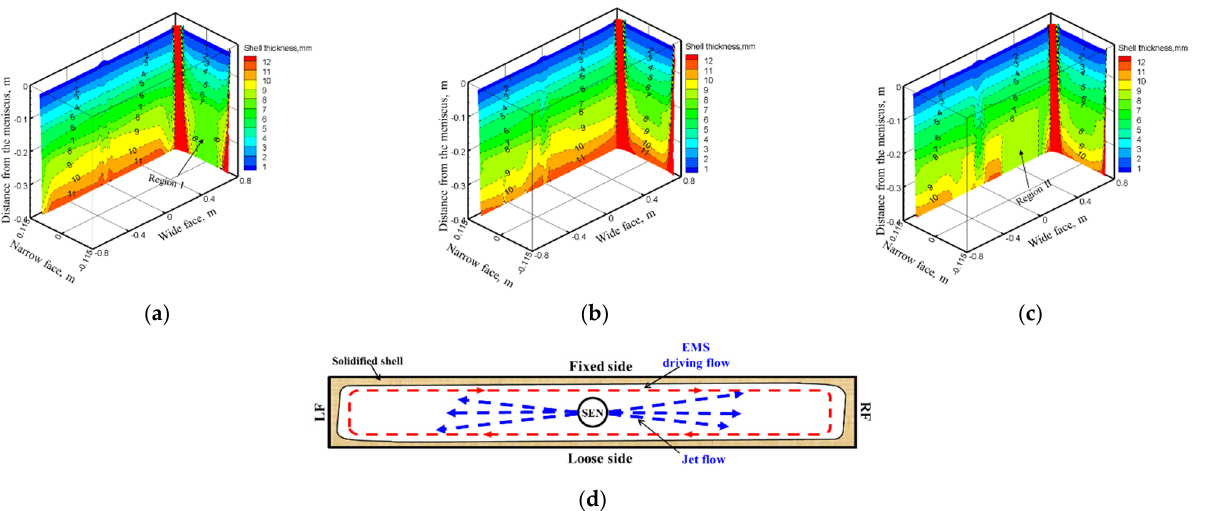
Figure 7. 3D variation of solidified shell thickness along the casting direction under different EMS currents: ( a ) 0 A, ( b ) 400 A, ( c ) 700 A, ( d ) schematic of transverse flow near jet flow with EMS.